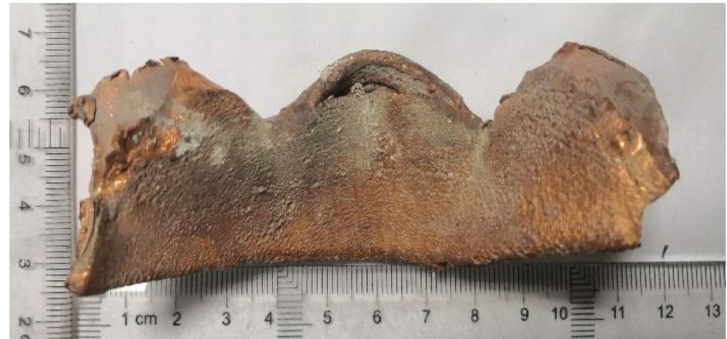
Figure 6. Linear explosively formed penetrator (LEFP) shape.